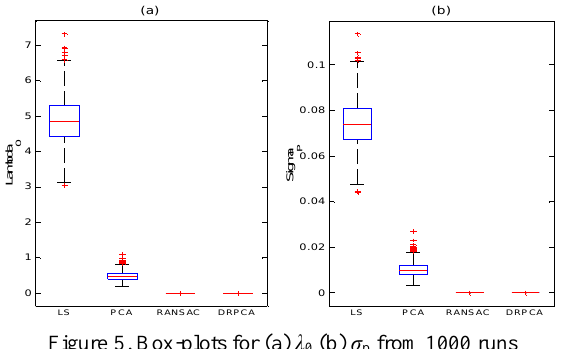
Figure 5. Box-plots for (a) λ 0 (b) σ p from 1000 runs